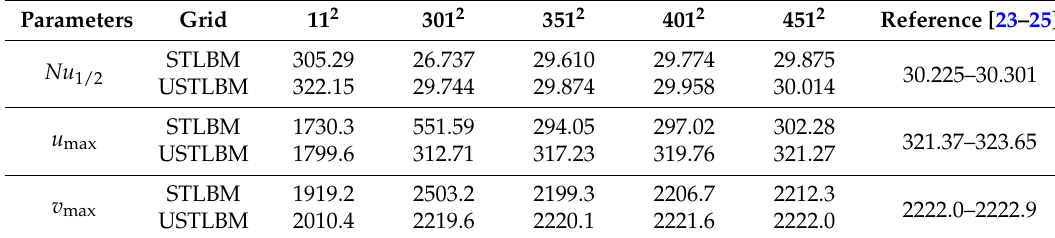
Table 4. Comparisons of flow parameters in Ra = 10 8 at different mesh